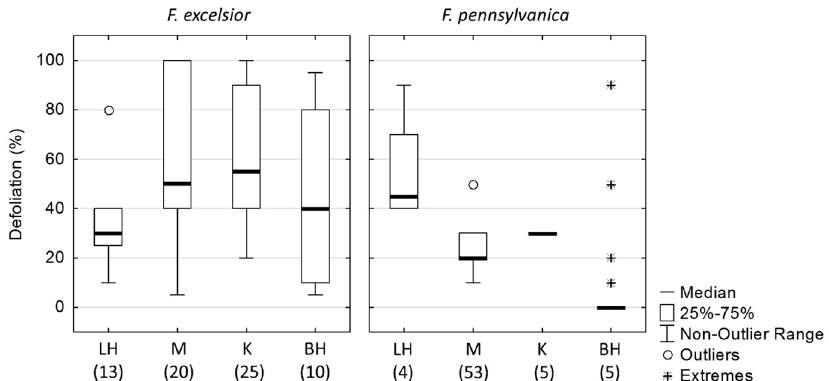
Figure 5. Comparison of crown defoliation (in percentages) of F. excelsior and F. pennsylvanica